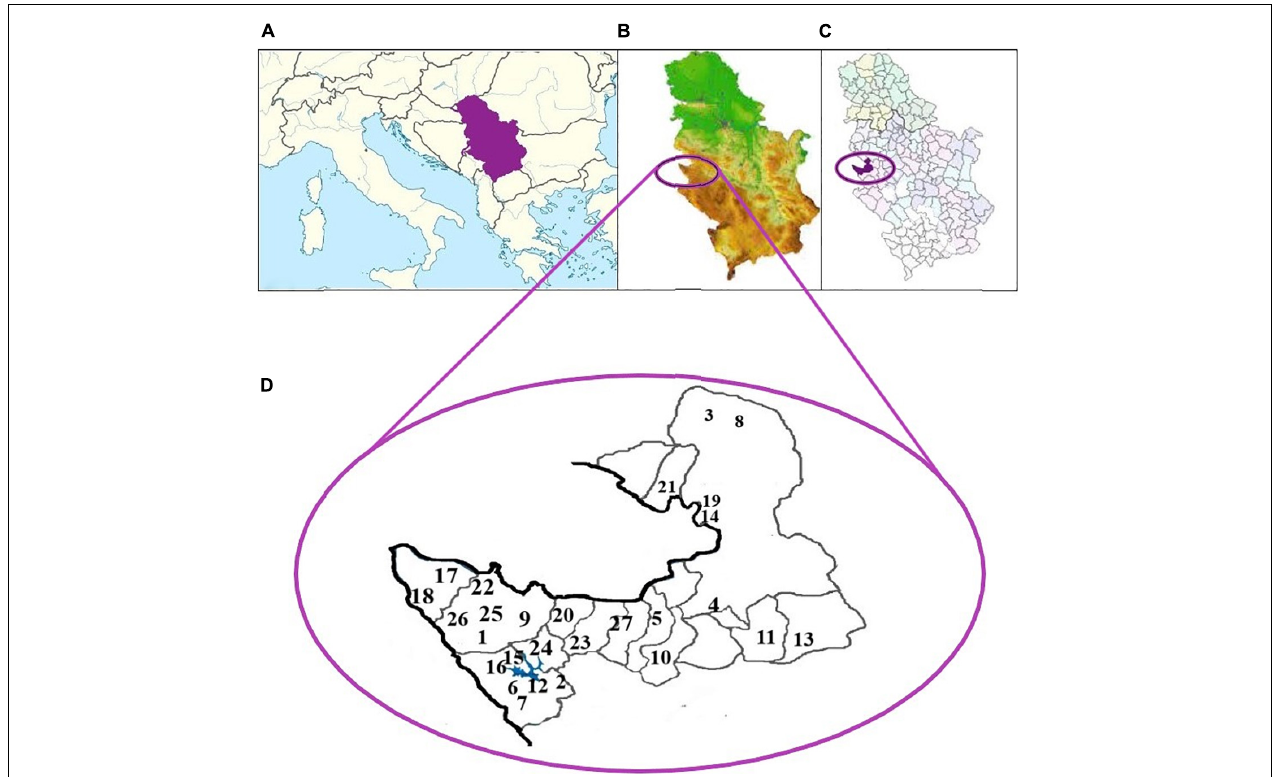
FIGURE 1 | (A) Regional map of Europe with Serbia highlighted; (B) geographical map of Serbia with the Tara Mountain region highlighted in the Western part of Serbia; (C) municipal map of Serbia with the Tara Mountain region highlighted in the Western part of Serbia; (D) twenty-seven locations of honey sampled in the Tara Mountain